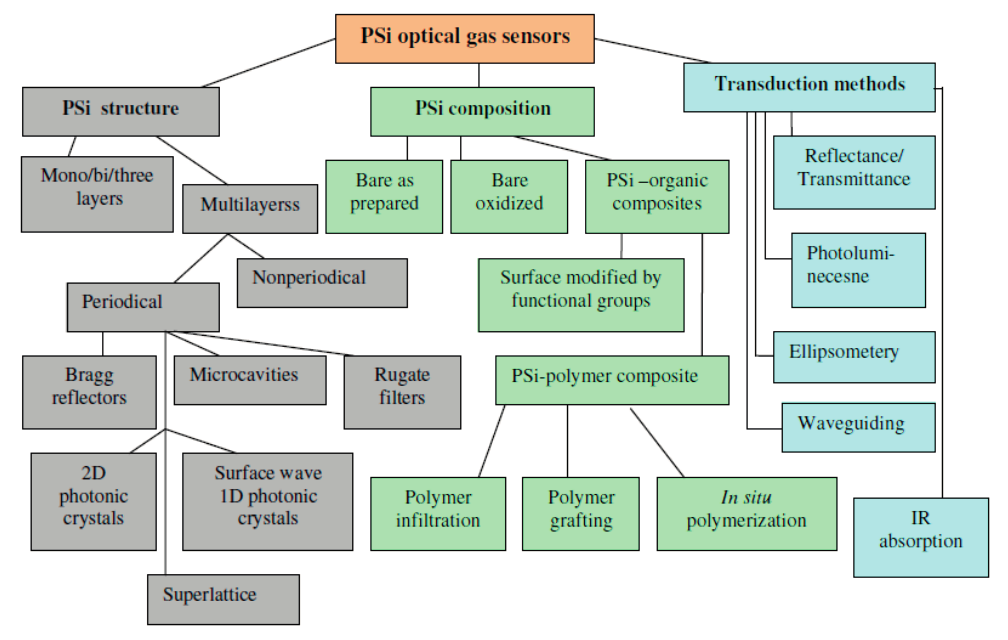
Figure 1. Major components of PSi optical gas